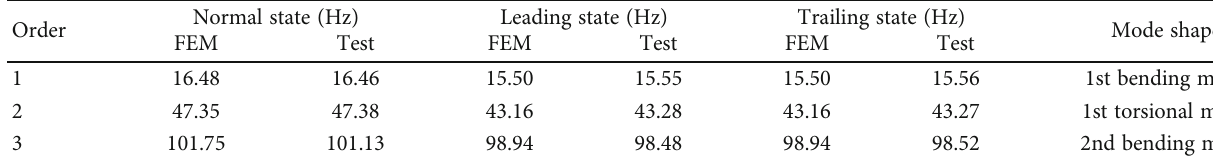
Table 1: Three lowest-order mode frequencies of the wing.